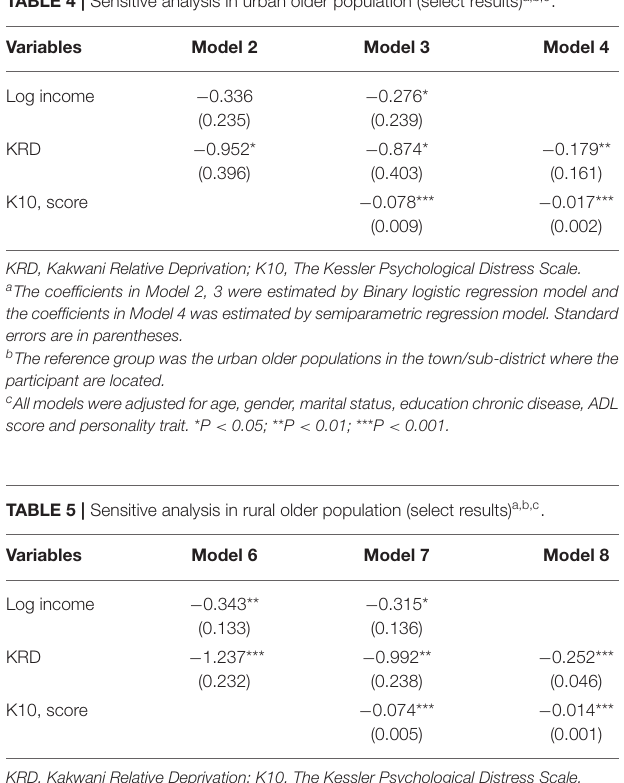
TABLE 4 | Sensitive analysis in urban older population (select results) a,b,c .